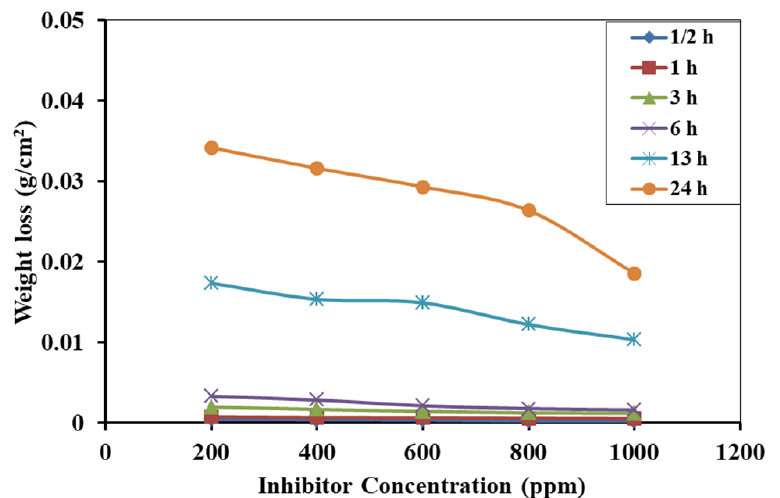
Figure 2. Variation of weight loss with different concentrations of AV alkaloids on MS in 1M H 2 SO 4 solution at 20 ° C at different intervals of immersion time.